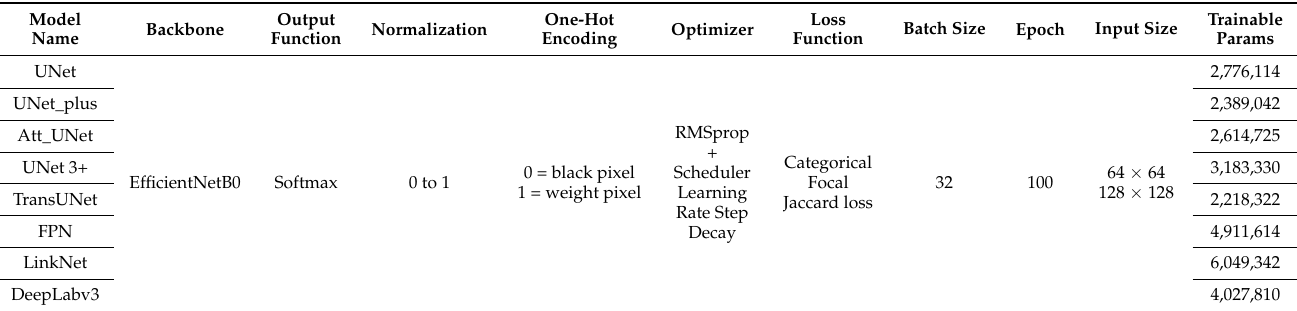
Table 2. The selected segmentation models and their